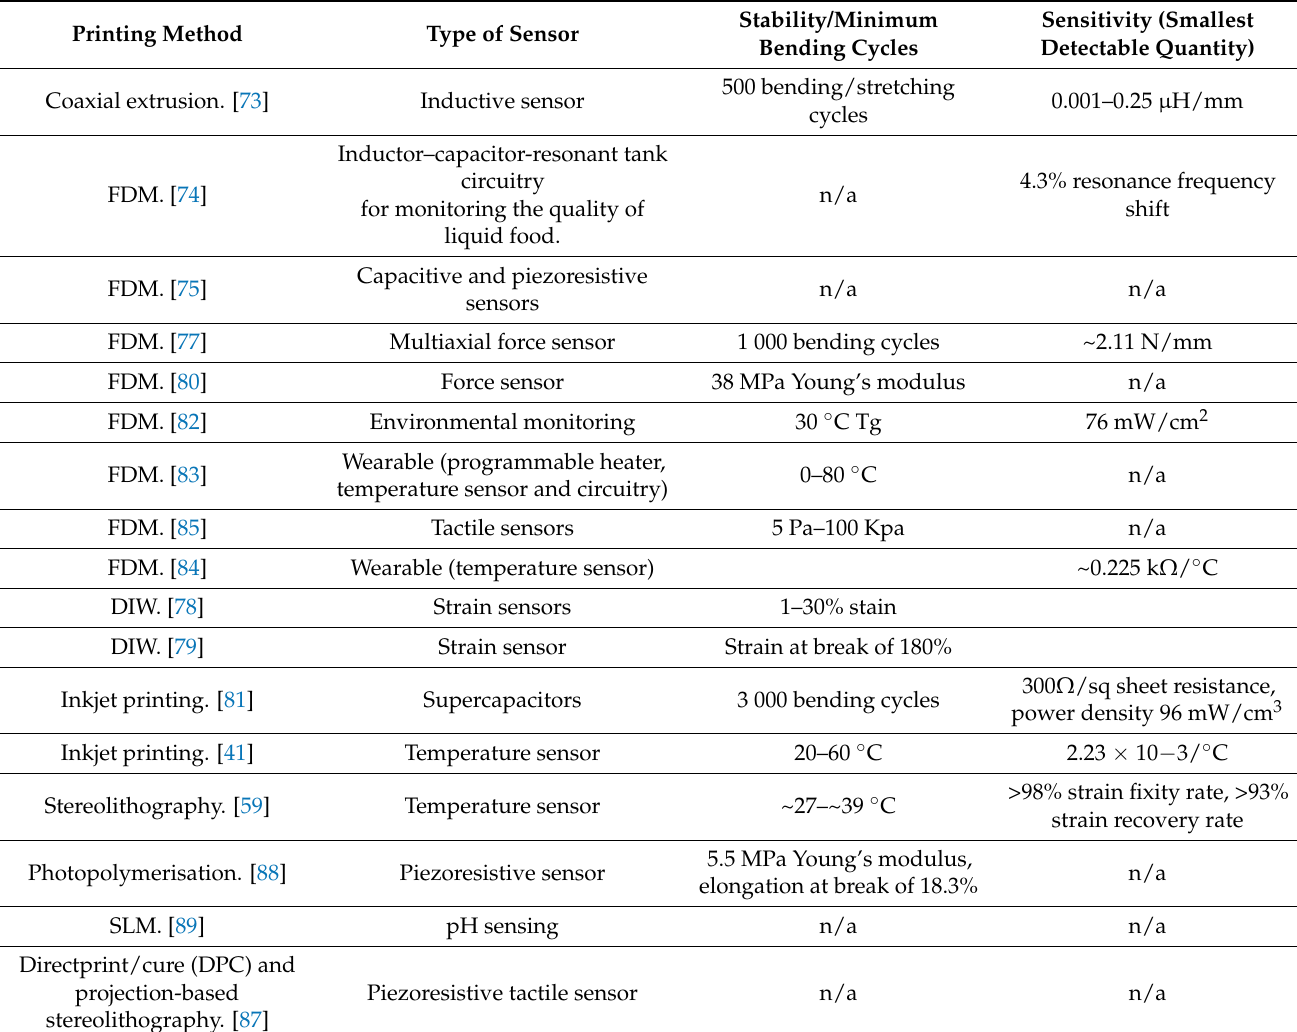
Table 2. Examples of additively manufactured (3D printed) sensors and some key characteristics studied in literature.